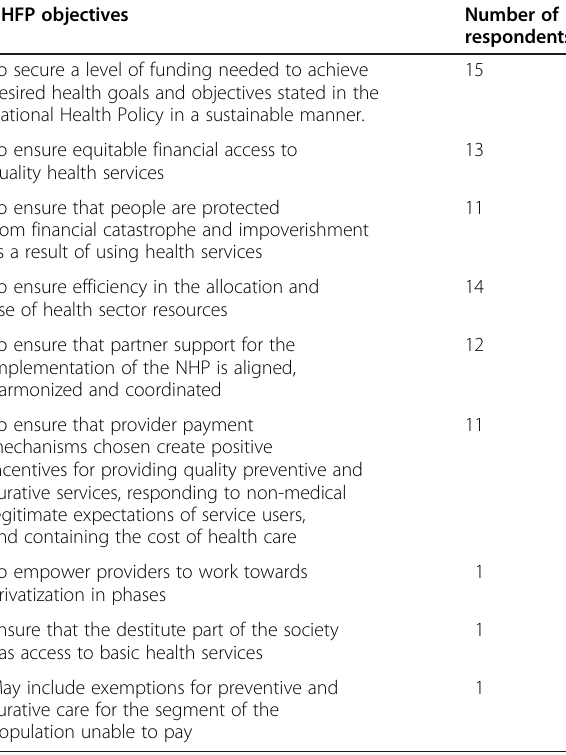
Table 4 Objectives of the national health financing